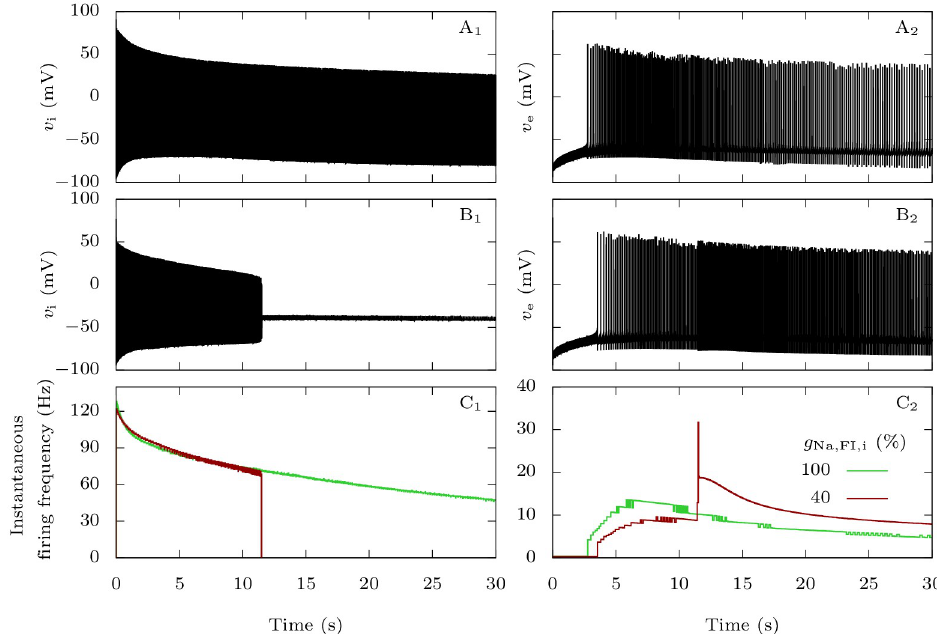
Fig 12. Effect of Na V 1.1 epileptogenic mutations on the firing frequency of the pyramidal neuron. When both neurons are coupled, taking as initial condition the steady-state when there is no external input, we applied external inputs g D,i = g D,e = 0.3 mS � cm − 2 . We tested both the default parameters, which represent a wild-type GABAergic neuron, and a sodium fast-inactivating maximal conductance g Na,FI,i reduced to 40% of its default value, to model epileptogenic mutations of Na V 1.1. A : Voltage of the GABAergic ( A 1 ) and pyramidal ( A 2 ) neurons in the wild-type condition. B : Voltage of the GABAergic ( B 1 ) and pyramidal ( B 2 ) neurons with the epileptogenic mutation. C : Instantaneous firing frequency of the GABAergic ( C 1 ) and pyramidal ( C 2 ) neurons in the two conditions.